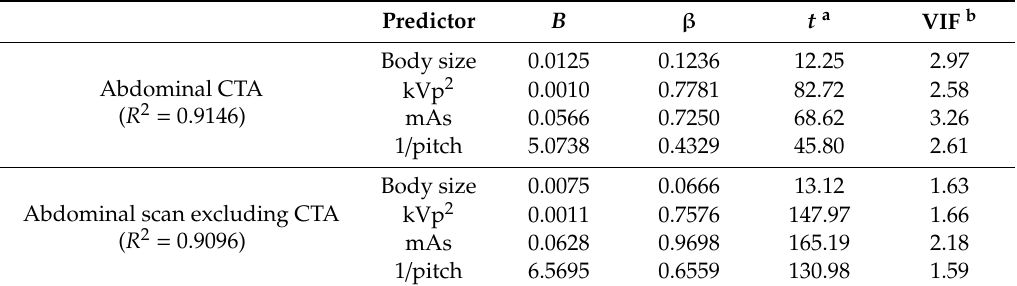
Table 6. Results of multivariate analysis for the abdominal scans performed using MDCT 64 .